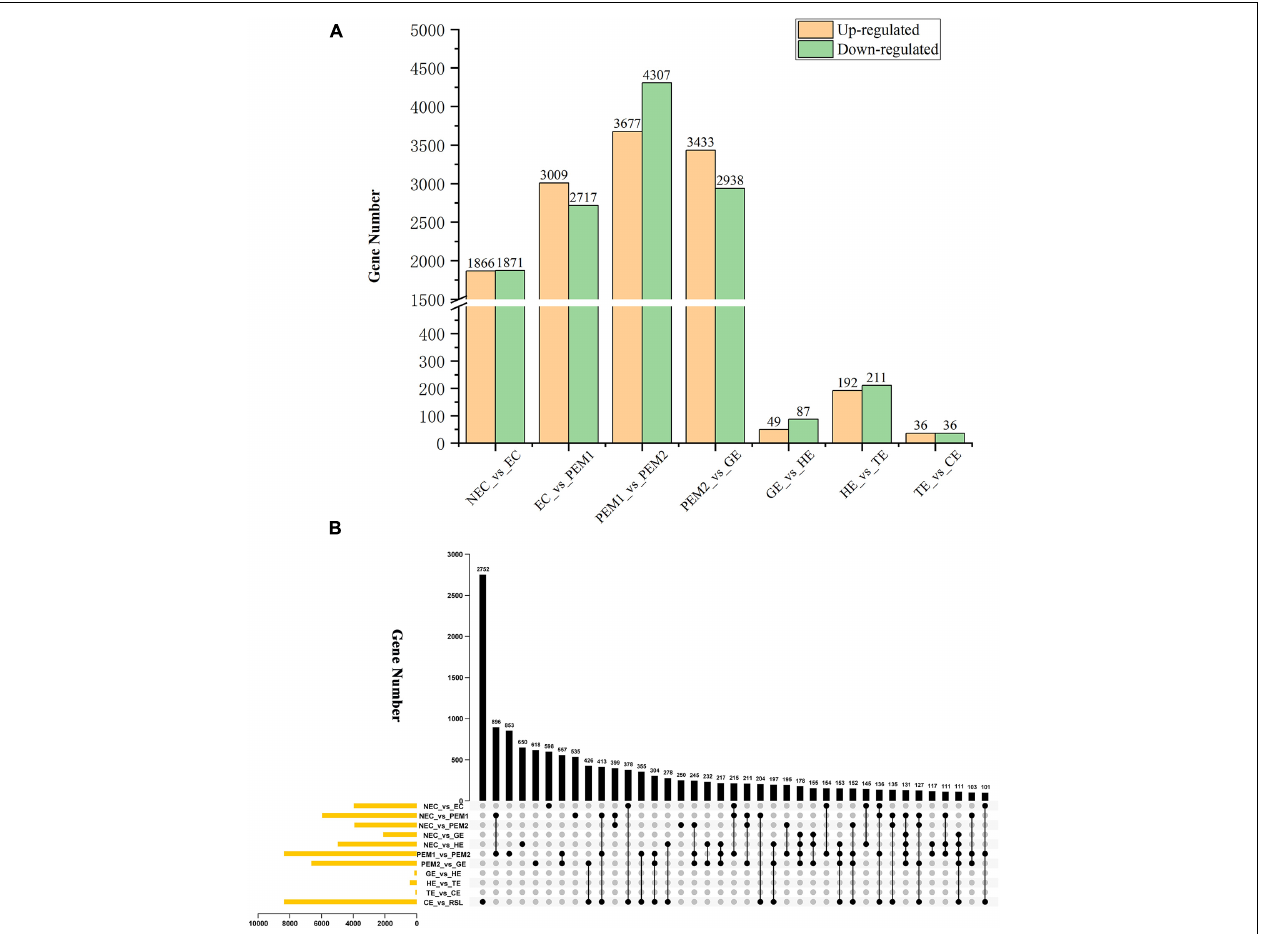
FIGURE 3 | Statistical analysis of differentially expressed unigenes in NEC, PEMs and different SE stages. (A) Statistic of Up/Down regulated genes in pairwise comparisons of NEC_vs_EC, EC_vs_PEM1, PEM1_vs_PEM2, PEM2_vs_GE, GE_vs_HE, HE_vs_TE and TE_vs_CE. (B) The Upset plot of expressed genes in eleven pairwise